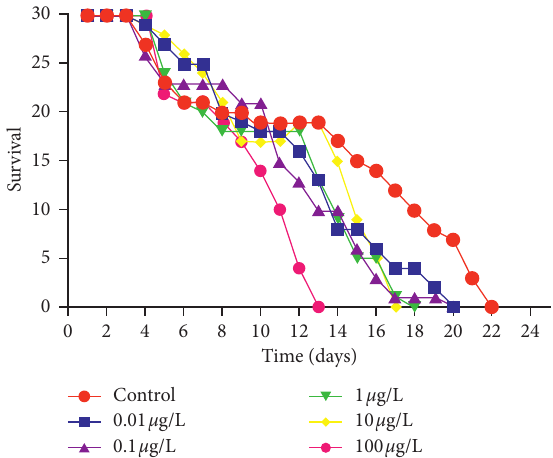
Figure 3: Effects of C. elegans on survival exposed to carbendazim. Data (mean ± SEM) are shown as the percentage value compared with the control group. The asterisks present the significance be- tween the each exposure group and control group ( ∗ p < 0 . 05 and ∗∗ p < 0 .